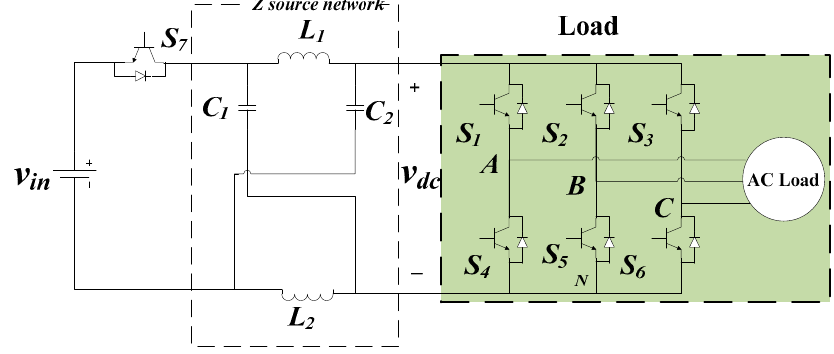
Figure 1. Bidirectional Z-source inverter main topology .